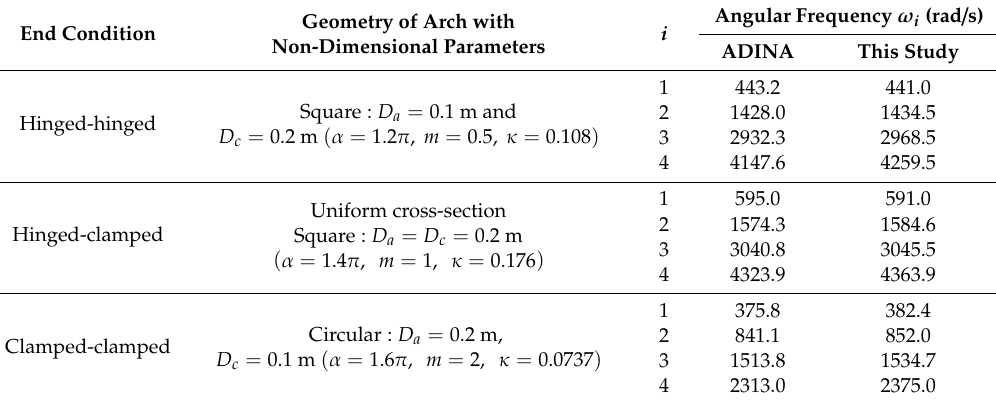
Table 1. Comparison of angular frequency ω i between ADINA and this study.